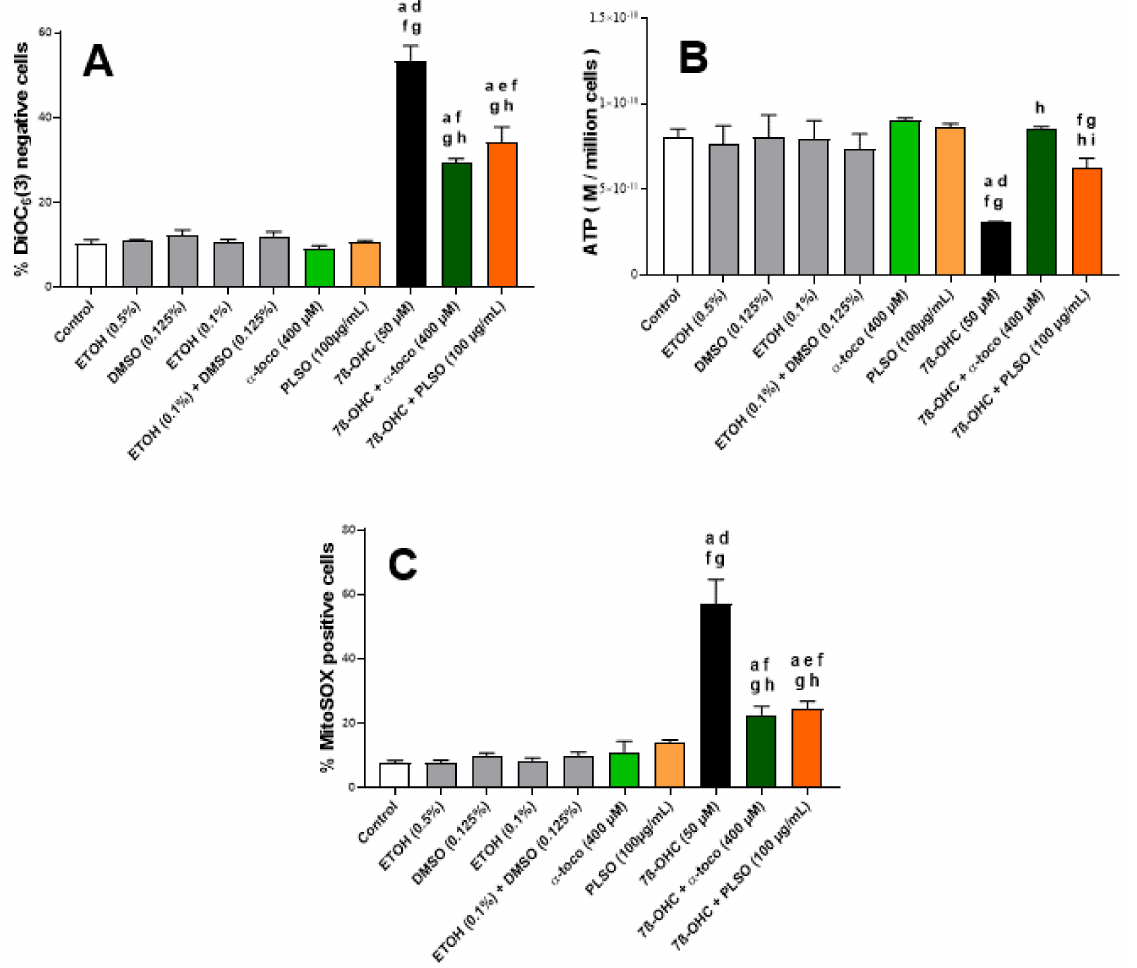
Figure 4. Effect of Pistacia lentiscus L. seed oil (PLSO) on 7 β -hydroxycholesterol-induced mitochondrial damage in C2C12 cells. C2C12 cells were incubated for 24 h with or without 7 β -OHC (50 µ M) in the presence or absence of PLSO (100 µ g/mL) or α -tocopherol (400 µ M). Mitochondrial transmembrane potential ( ∆Ψ m) ( A ), mitochondrial ATP produc- tion ( B ), and mitochondrial production of superoxide anion(O 2 •− ) ( C ) were measured. The data are presented as the mean ± SD of two independent experiments performed in triplicate. A multiple comparative analysis between the groups, taking into account the interactions, was carried out using an ANOVA test followed by a Tukey’s test. A p -value less than 0.05 was considered statistically significant. The statistically significant differences between the groups, which are indicated by different letters, take into account the vehicle used. a: comparison versus control; b: comparison versus ETOH (0.5%); c: com- parison versus DMSO (0.125%); d: comparison versus ETOH (0.1%); e: comparison versus (ETOH (0.1%) + DMSO (0.125%)); f: comparison versus α -toco (400 µ M); g: comparison versus PLSO (100 µ g/mL); h: comparison versus 7 β -OHC (50 µ M); i: comparison versus 7 β -OHC (50 µ M) + α -toco (400 µ M). No significant differences were observed between the untreated (control) and vehicle-treated